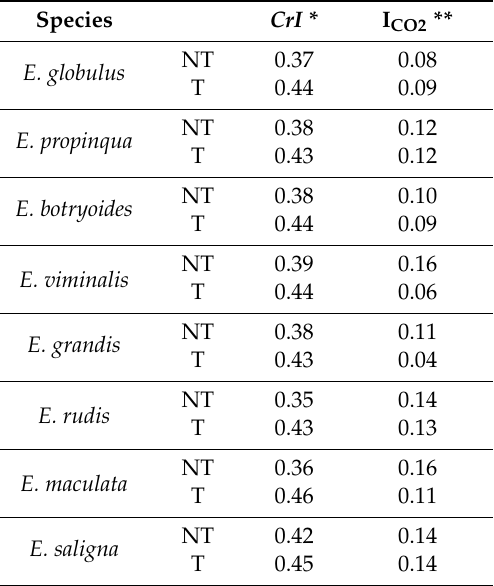
Table 2. Analysis of the woods before (NT) and after the treatment (T) by solid-state carbon nuclear magnetic resonance ( 13 C